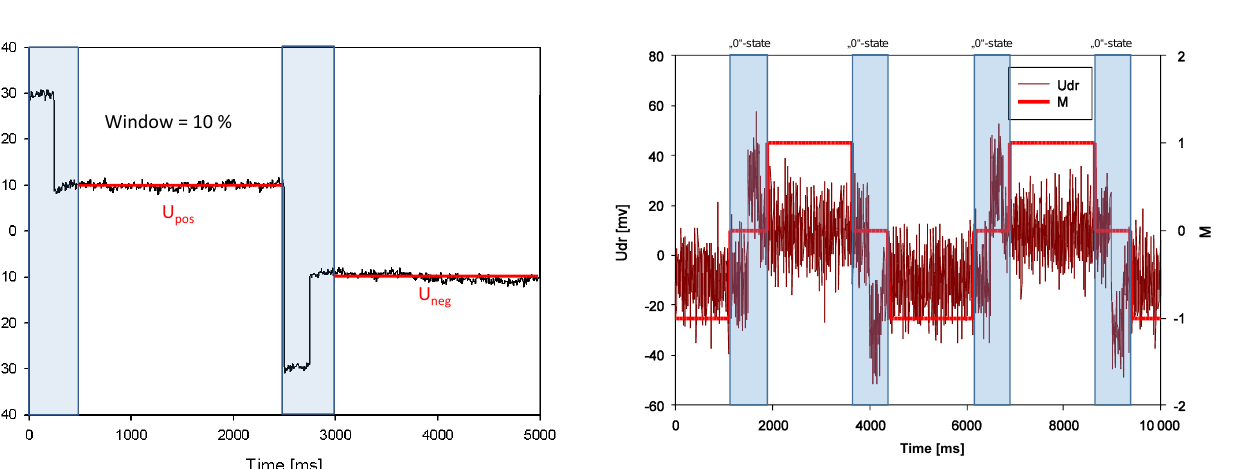
Figure 7. Determination of effective stacking window for calculat- ing the mean value at the plateaus for a synthetic signal containing a 250ms overshoot.